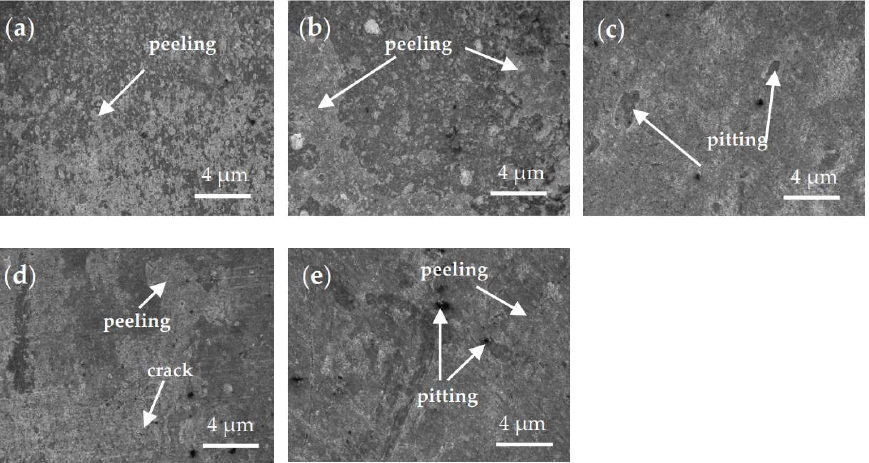
Figure 5. SEM images of the rust-removed surface: ( a ) 48 h in 3.5% NaCl; ( b ) 144 h in 3.5% NaCl; ( c ) 288 h in 3.5% NaCl; ( d ) 144 h in 2.0% NaCl; and ( e ) 144 h in 5.0%